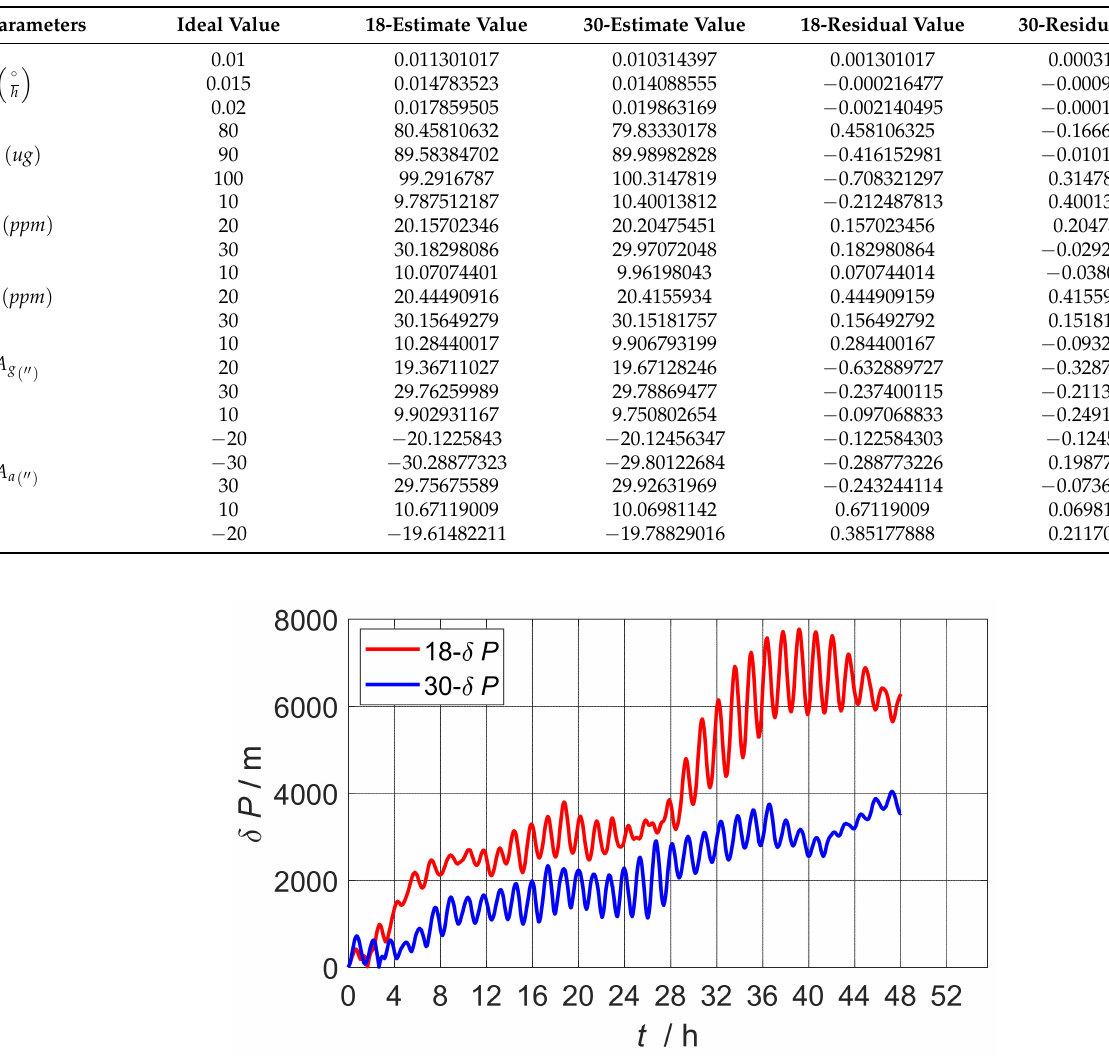
Figure 2. Comparison of positioning error of navigation after calibration compensation of 30-position scheme and 18-position